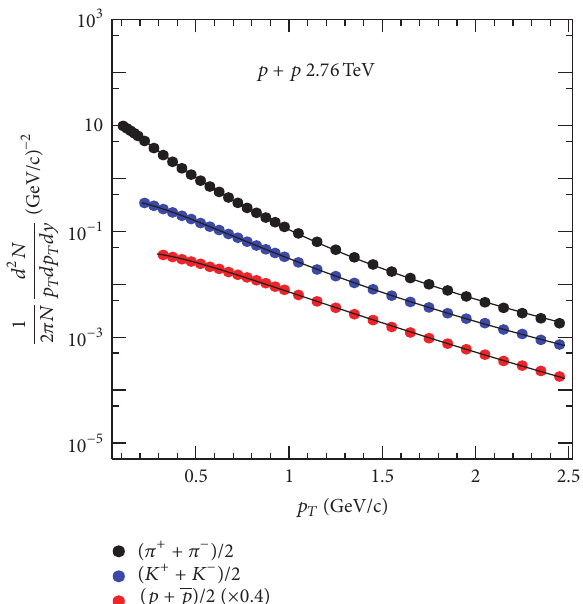
Figure 14: Fitting of invariant 𝑝 𝑇 spectra with Tsallis distribution using (7) for (𝜋 + +𝜋 − )/2 [19, 20], (𝐾 + +𝐾 − )/2 [19, 20], and (𝑝+𝑝)/2 [19, 20] in 𝑝+𝑝 collisions at √𝑠 NN = 2.76 TeV. Symbols represent the data points and line is the fit function.